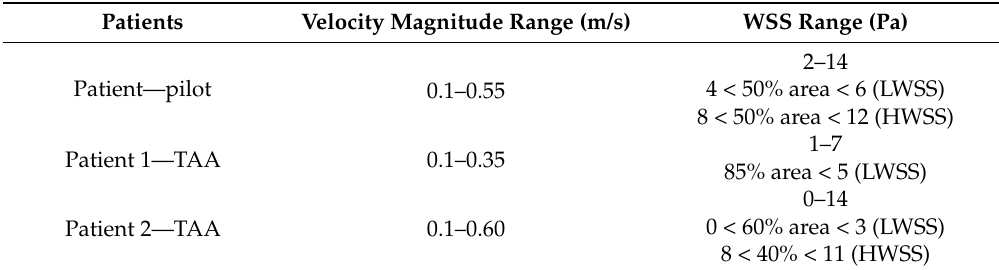
Table 2. Velocity magnitude and WSS ranges.